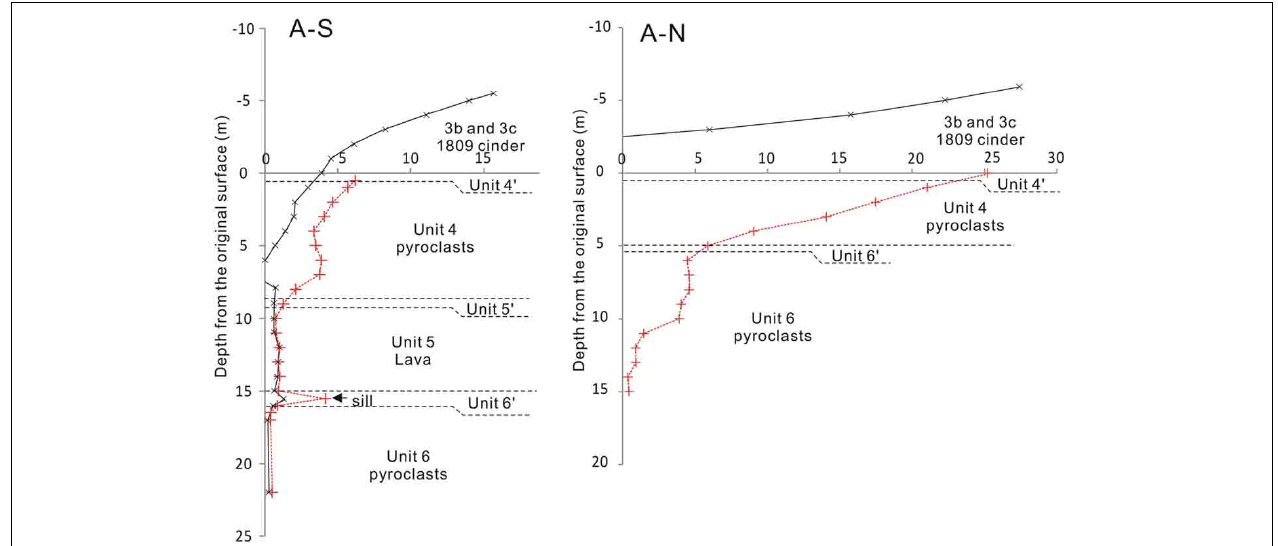
FIGURE 7 | Variations of the width of the feeder system in the southern (A–S) and northern (A–N) walls of the 1809 crater A. Red lines and symbols show the width of the feeder. Black lines show the shape of the crater and the cavity in the